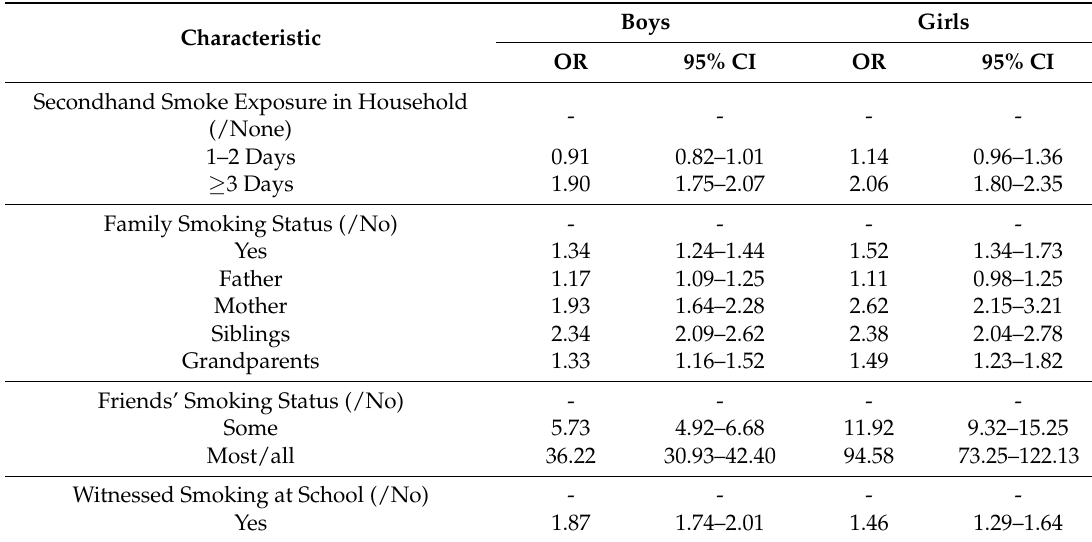
Table 3. Odds ratios (95% CI) for current smoking a .